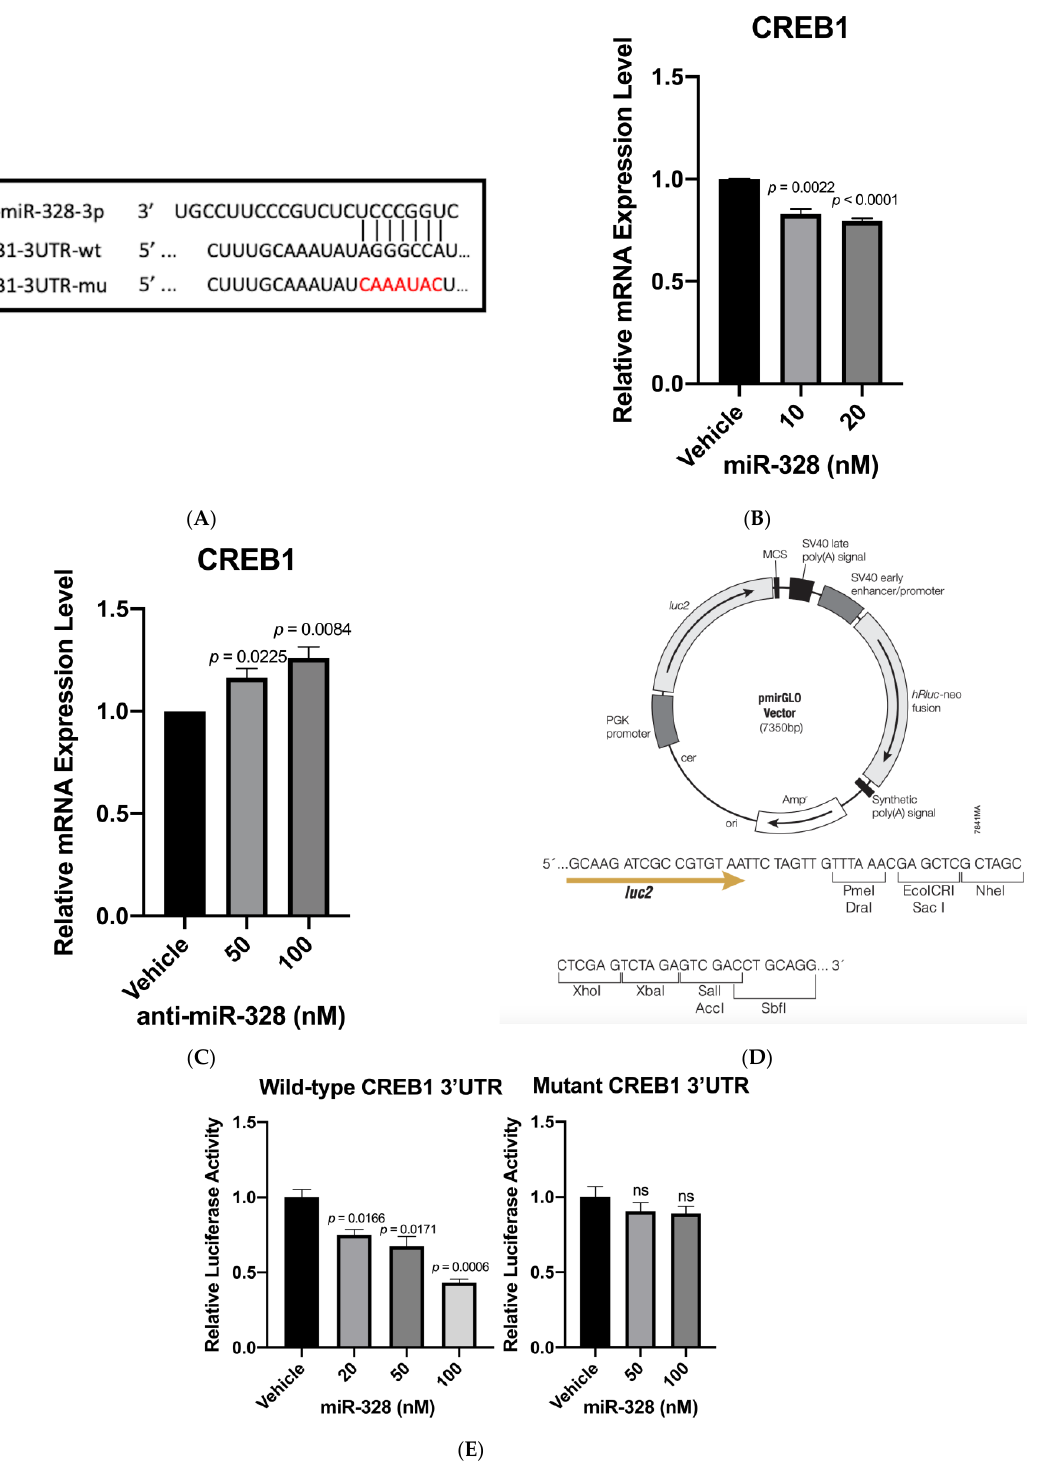
Figure 1. Identification of CREB1 as a miR-328 target. ( A ) The wild-type and mutant sequences at the miR-328 binding site on CREB1 3 (cid:48) UTR. wt = wild-type; mu = mutant. ( B ) MiR-328 knocks down the CREB1 RNA expression level. n = 3 for each group. ( C ) Anti-miR-328 increases CREB1 RNA levels. n = 3 for each group. ( D ) The commercially available vector used in the luciferase study to carry either wild-type or mutant 3 (cid:48) UTR. ( E ) MiR-328 knocks down the luciferase activity in the cells containing plasmid vectors with wild-type CREB1 3 (cid:48) UTR but not mutant CREB1 3 (cid:48) UTR. n = 3 for each